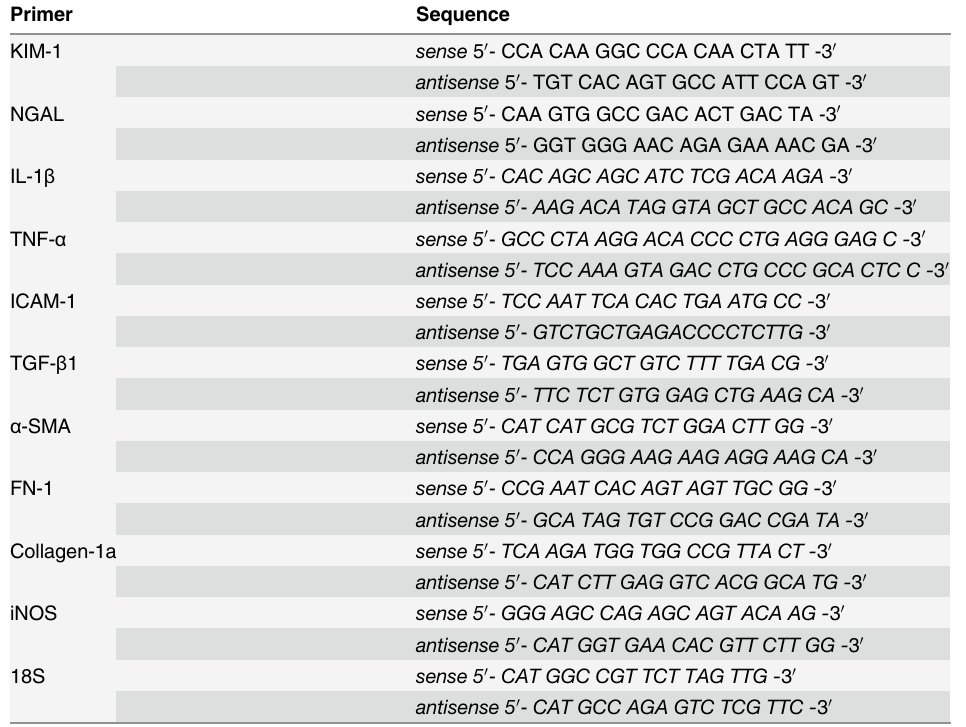
Table 1. Sequences of the primers used for QPCR.